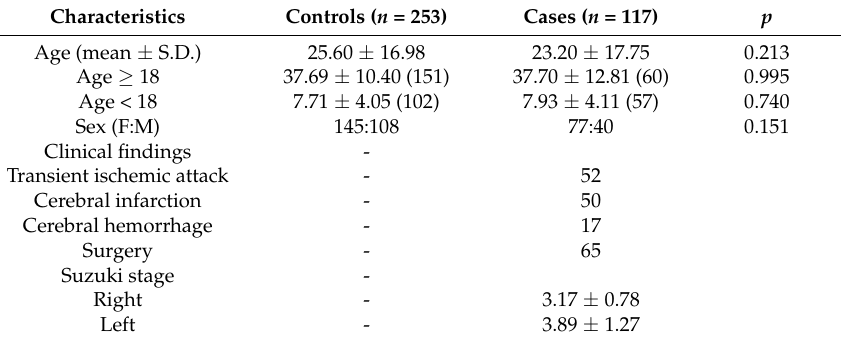
Table 1. Demographic characteristics of moyamoya disease patients and